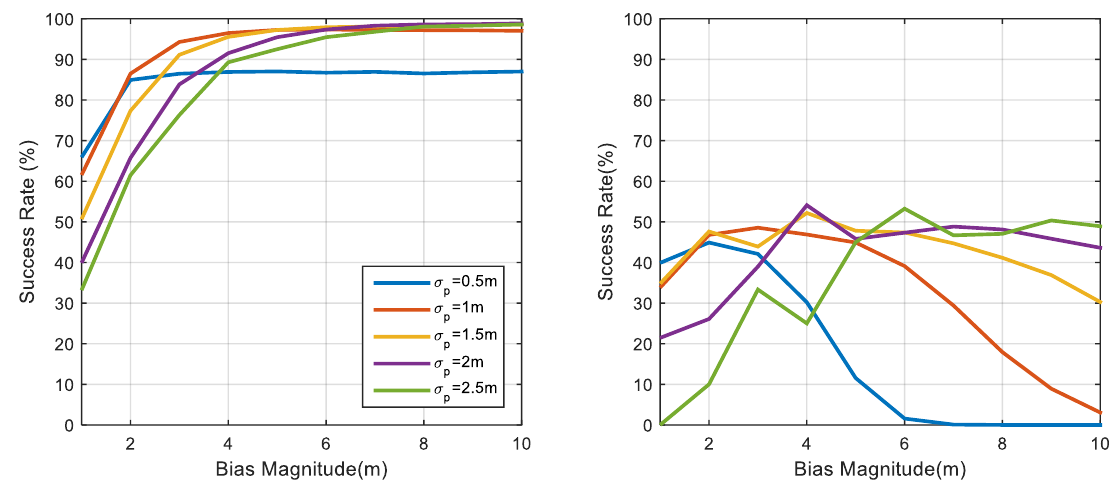
Figure 10. Compare of success rate with different NLOS bias and measurement noise for the MC algorithm ( Left ) and the ML method ( Right ).